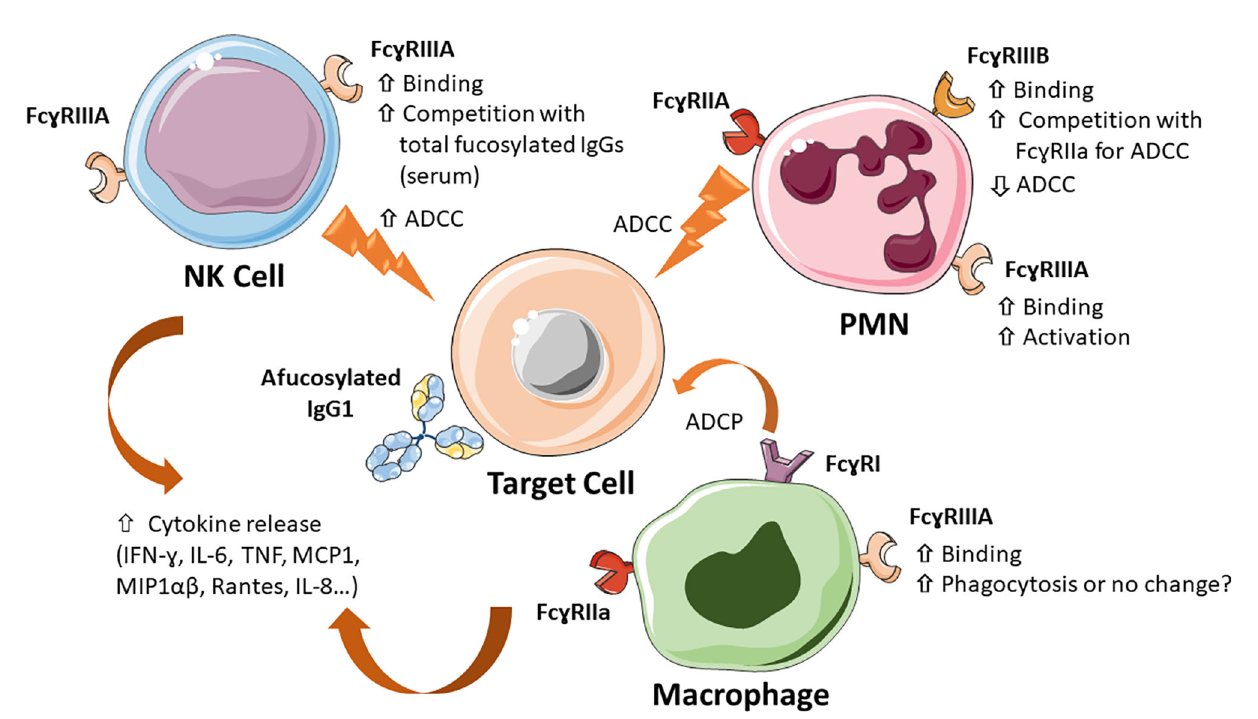
FIGURE 4 | Major mechanisms of action of Fc core afucosylated IgG1 antibodies. IgG1 antibodies lacking Fc core a -1,6-fucose show a 10-100 fold increased binding to Fc ɣ RIIIA and Fc ɣ RIIIB on the indicated immune cells (NK, monocytes/macrophages and PMN), which results in increased ADCC by NK cells, enhanced competition with plasma IgGs, increased PMN activation, increased inhibition of Fc g RIIA-mediated ADCC by PMN, induced by some antibodies (e.g. anti-EGFR mAbs). The effect of monocyte/macrophage induced ADCP is less clear. Low Fc core fucose can also increase release of cytokines, such as IL-6, TNF- a and IL-8, both in vitro and in vivo